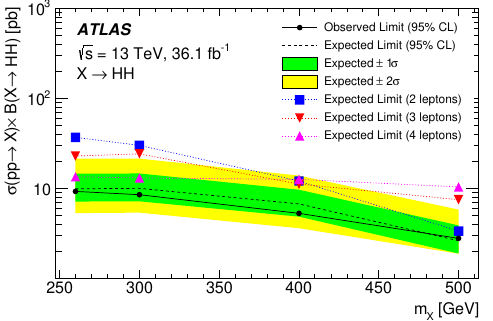
Figure 3 . Expected and observed 95% CL exclusion limits set on the cross-section times branching ratio of resonant HH production as a function of m X . Limits are shown for each channel individually as well as for the combination of the channels. Statistical and systematic uncertainties are included.